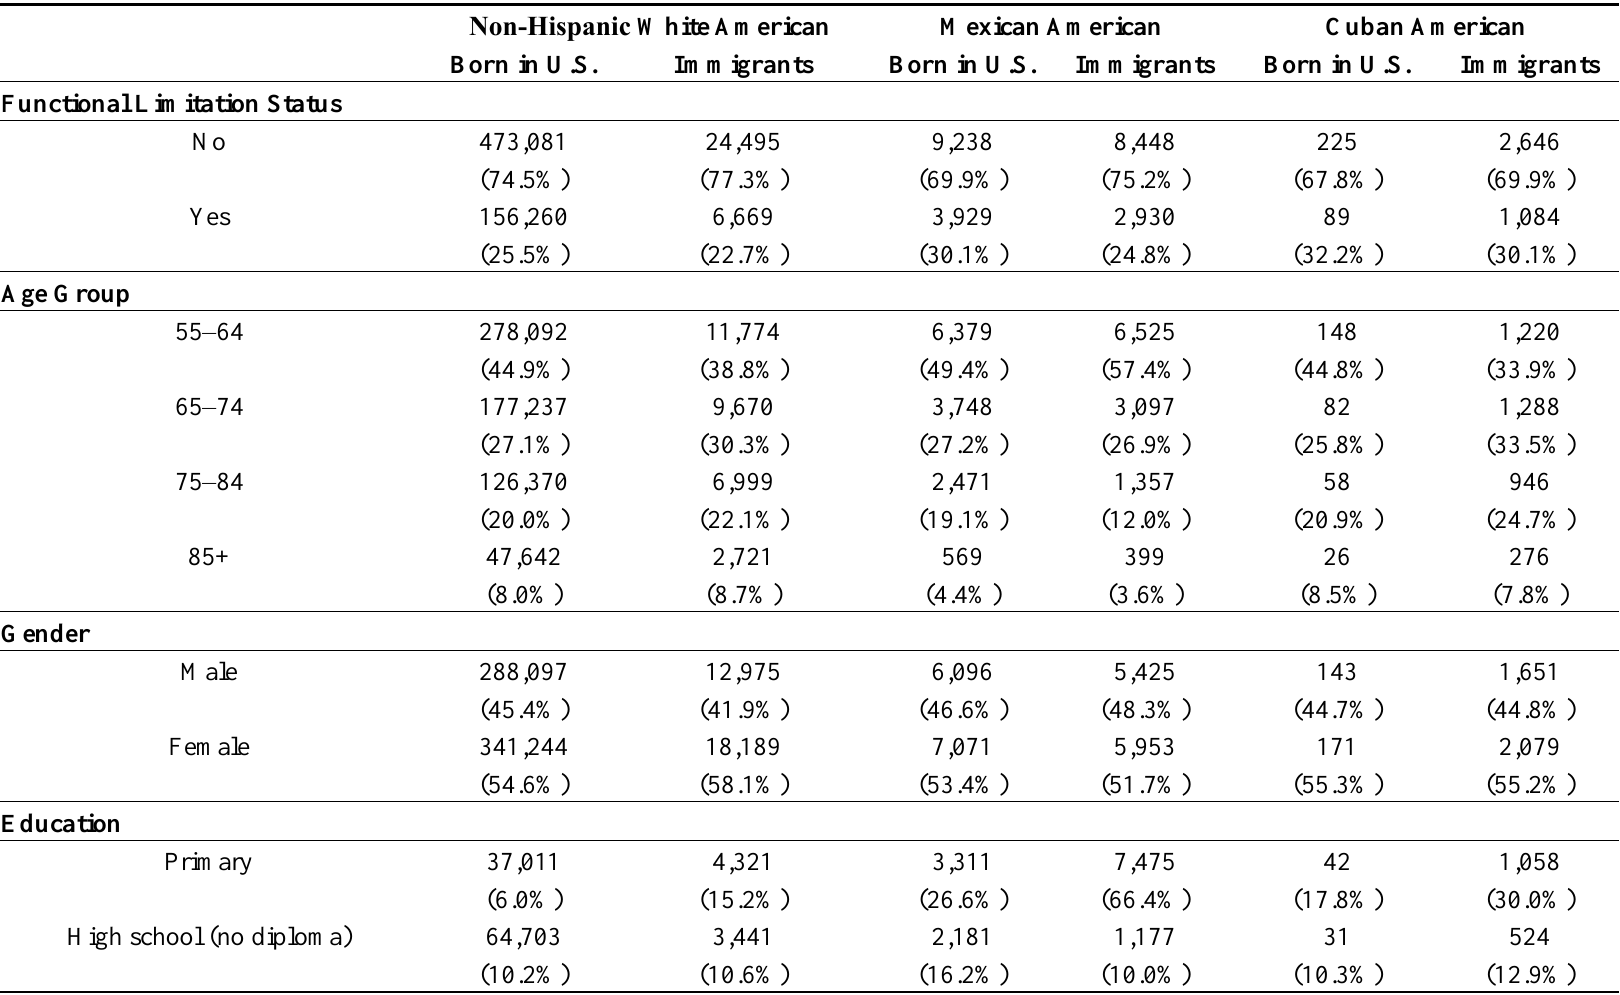
Table 1. Socio-demographic and immigration-related factors associated with functional limitations among older adults identified by ethnicity and immigrant status (unweighted sample size and weighted